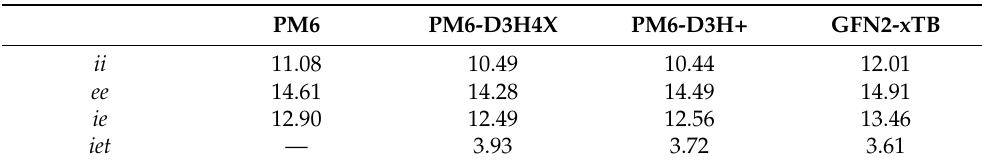
Table 1. R P distances (in Å) for the several conformers of the corannulene pincer according to the four methods used in this study.